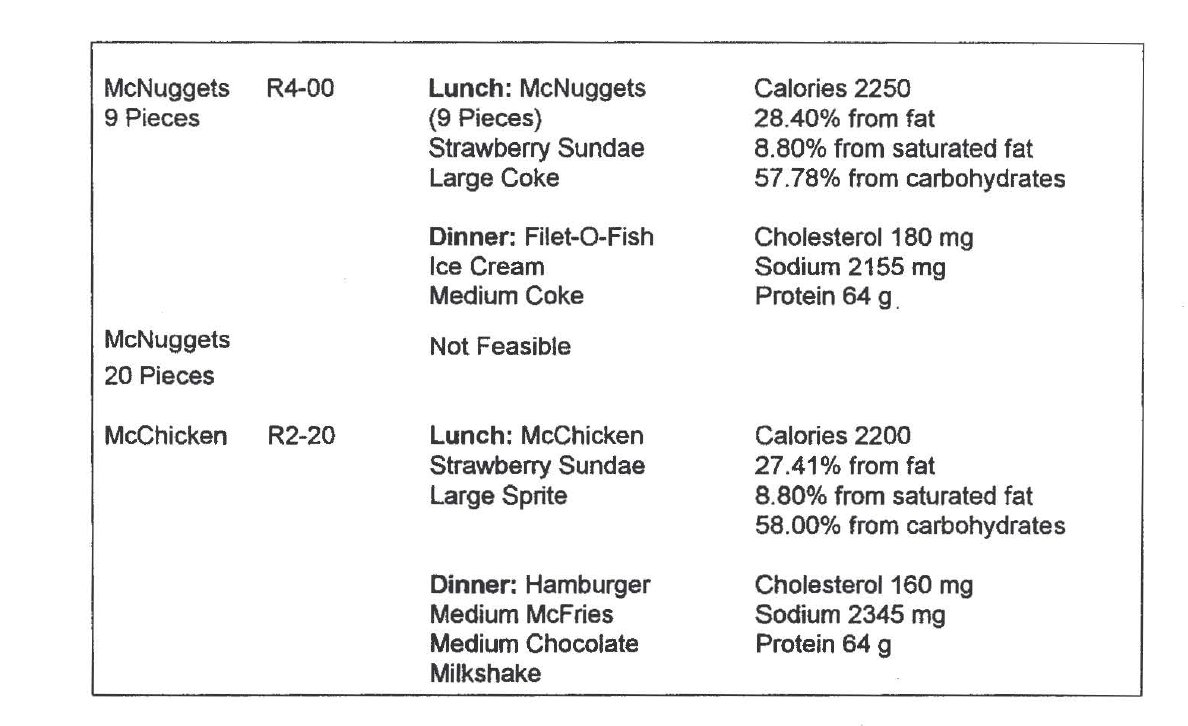
Table 5. Optimal daily diets that include particular McDonald's main